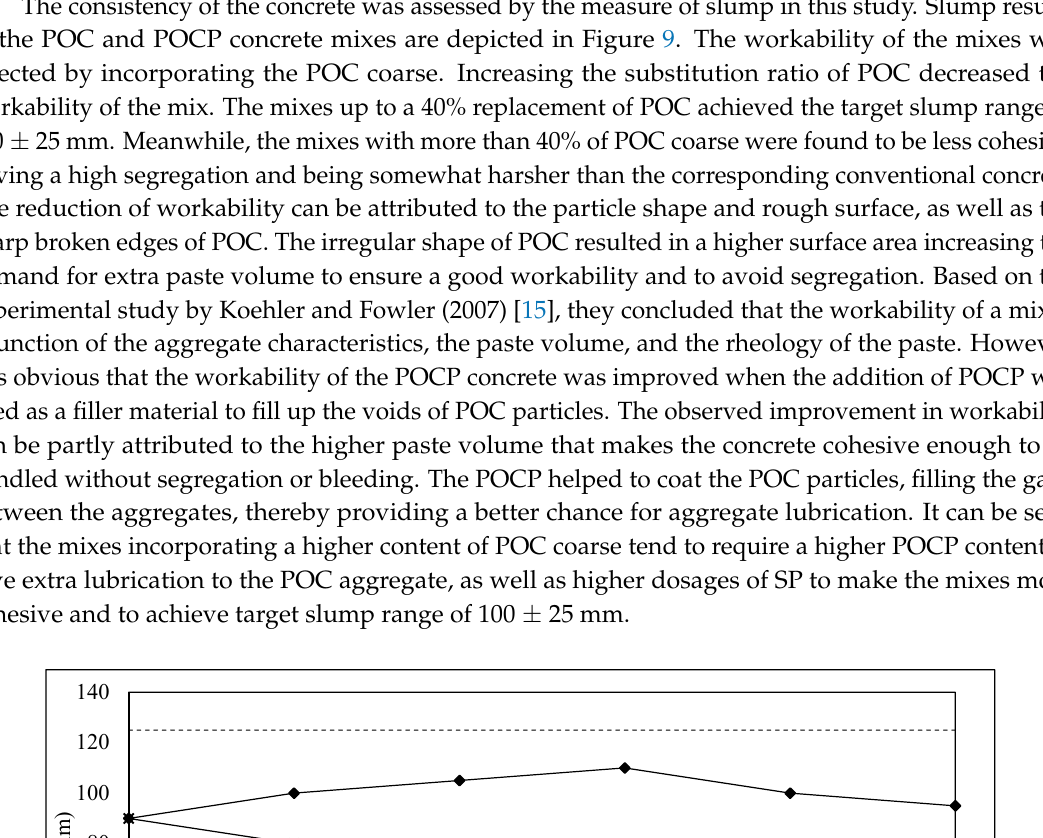
Figure 10. Fresh density of POCP concrete and POC concrete.